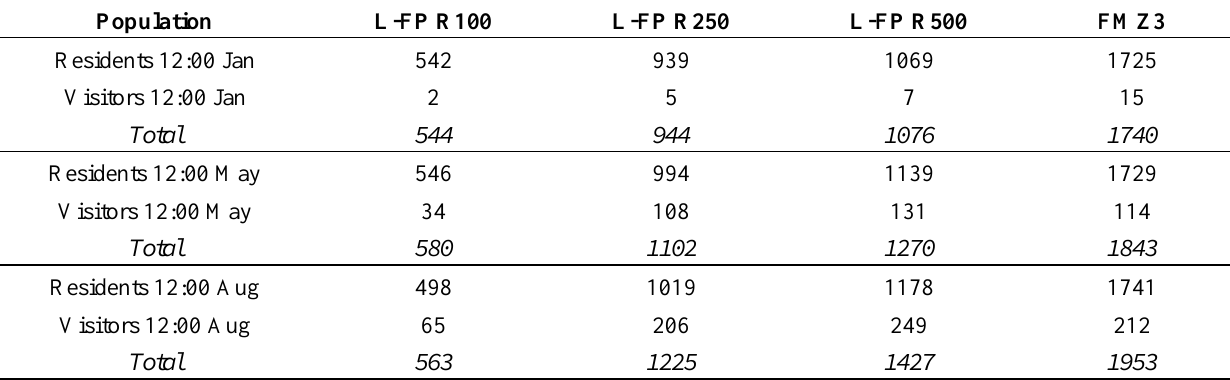
Table 3. Daytime usually resident and visitor population exposure to three LISFLOOD-FP inundation scenarios (R = return period) and EA flood map zone three for January, May and August (increasing levels of inundation left to